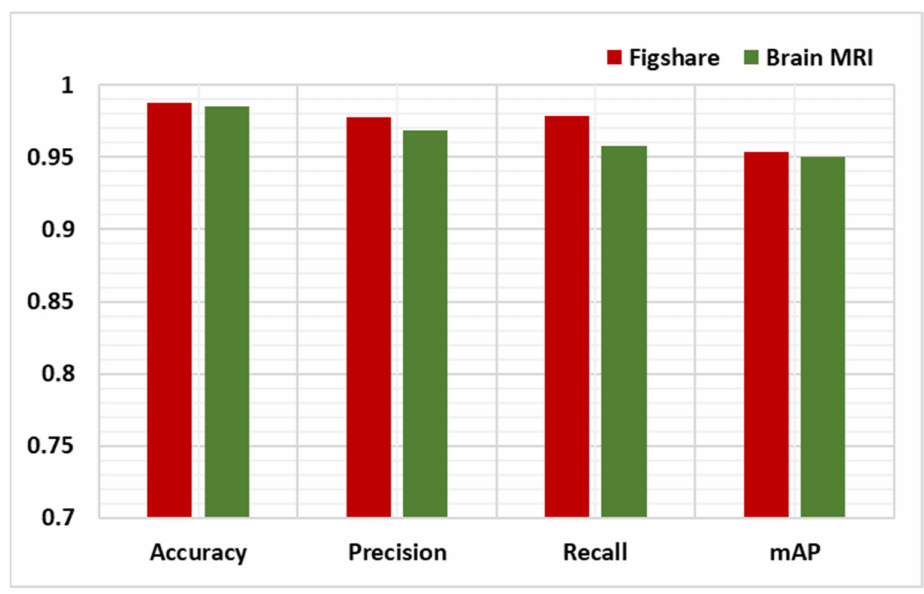
Figure 7. Proposed approach results over both